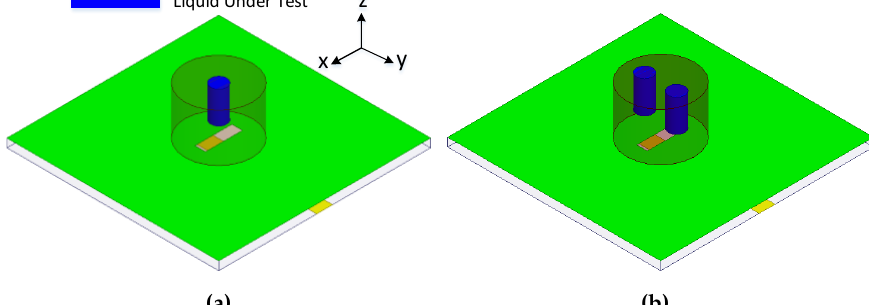
Figure 5. Types of DRA-based sensors ( a ) Type 1: One cylindrical microwell for liquid testing (LT) ( b ) Type 2: Two cylindrical microwells for LT.